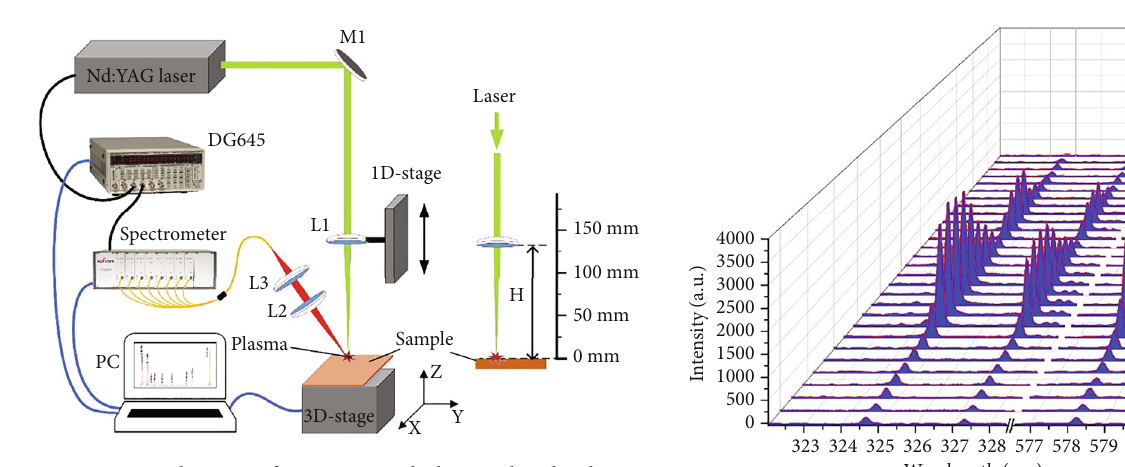
Figure 1: Schematic for picosecond laser-induced plasma spectroscopy with a variable lens-to-sample distance.